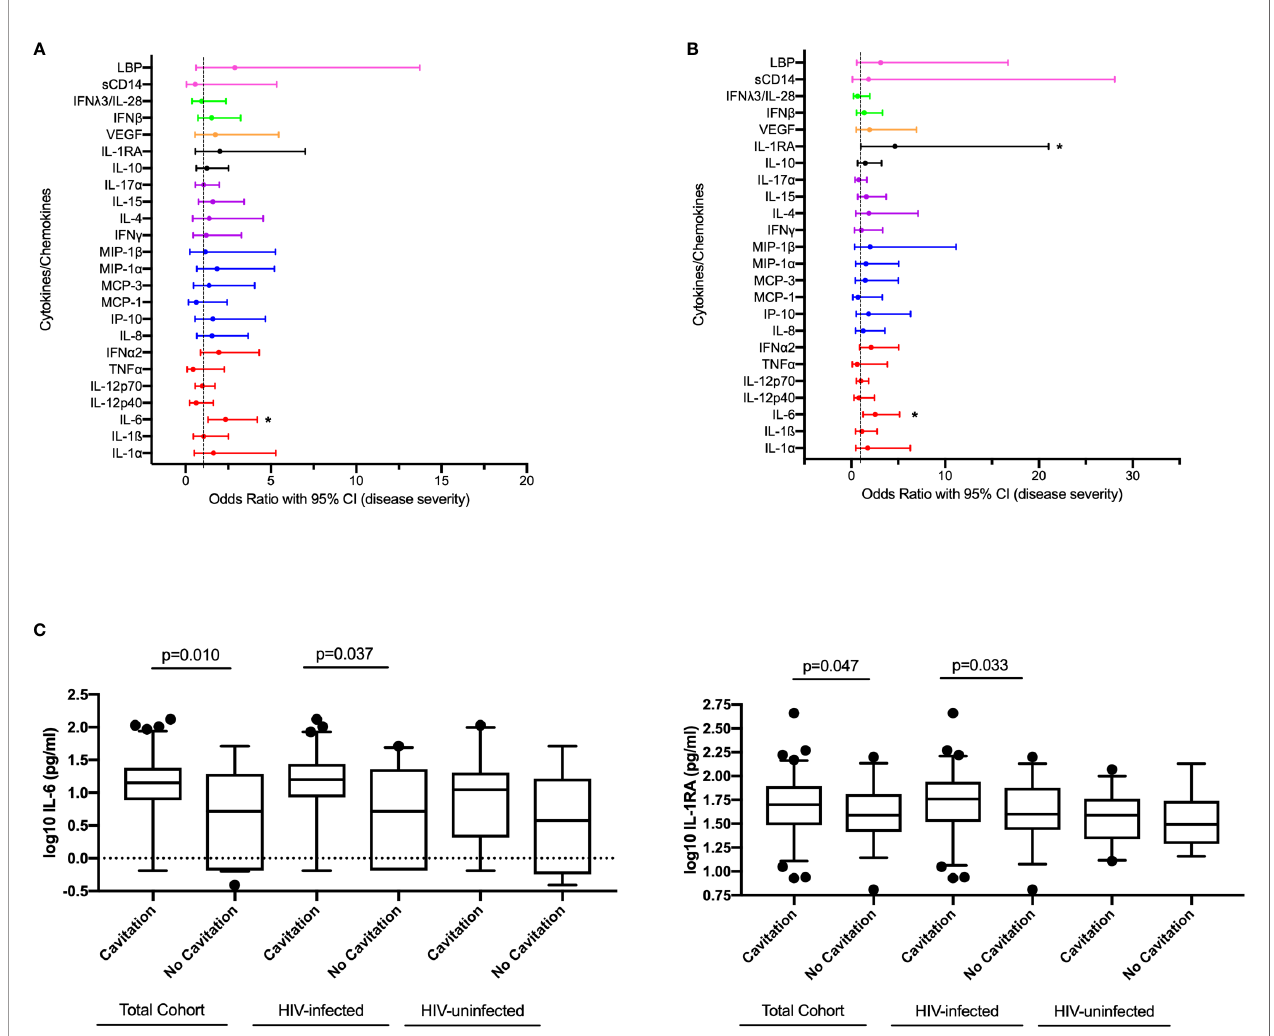
FIGURE 3 | Association between cytokine/chemokine expression measured at active TB and disease severity measured by lung cavitation (n=132) in both (A) univariable and (B) multivariable model. Individual associations are shown between 8-week culture conversion and pro-in fl ammatory cytokines (red), chemokines (blue), adaptive response cytokines (purple), anti-in fl ammatory (black), growth factors (orange), interferons (green) and plasma biomarkers (pink) with error bars depicting 95% con fi dence intervals. The dotted line at 1 is the interpretation of odds ratio. Asterisk in (A, B) indicates signi fi cant associations (p < 0.05). (C) IL-6 and IL-1RA plasma levels associated with cavitary versus non-cavitary disease in total cohort (Cavitation n=93, no cavitation n=39), HIV-infected participants (Cavitation n=63, no cavitation n=33) and HIV-uninfected individuals (Cavitation n=30, no cavitation n=6). Cytokines were plotted on log scale (Log 10), Box and Whiskers (5 – 95%). p-values shown on the graph (C) are the results of the multivariable logistic